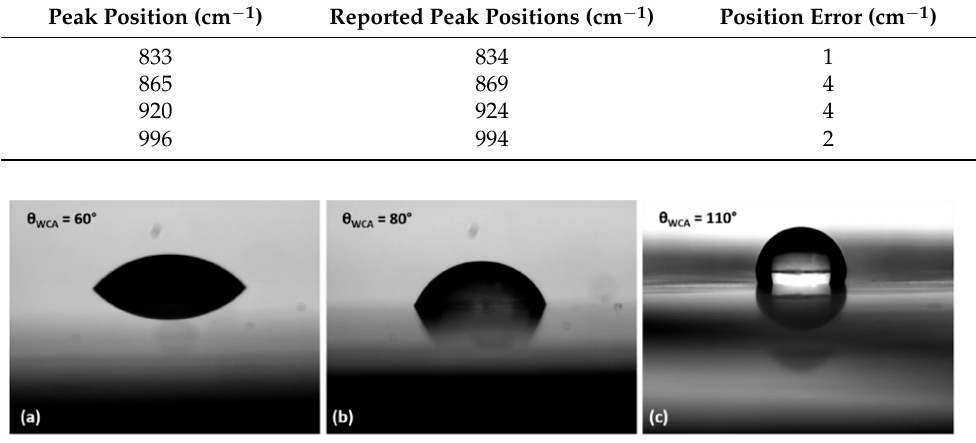
Figure 5. The photographs of water droplet on the sucrose coated surfaces with concentrations of 5 wt% ( a ), 10 wt% ( b ), and 15 wt% ( c